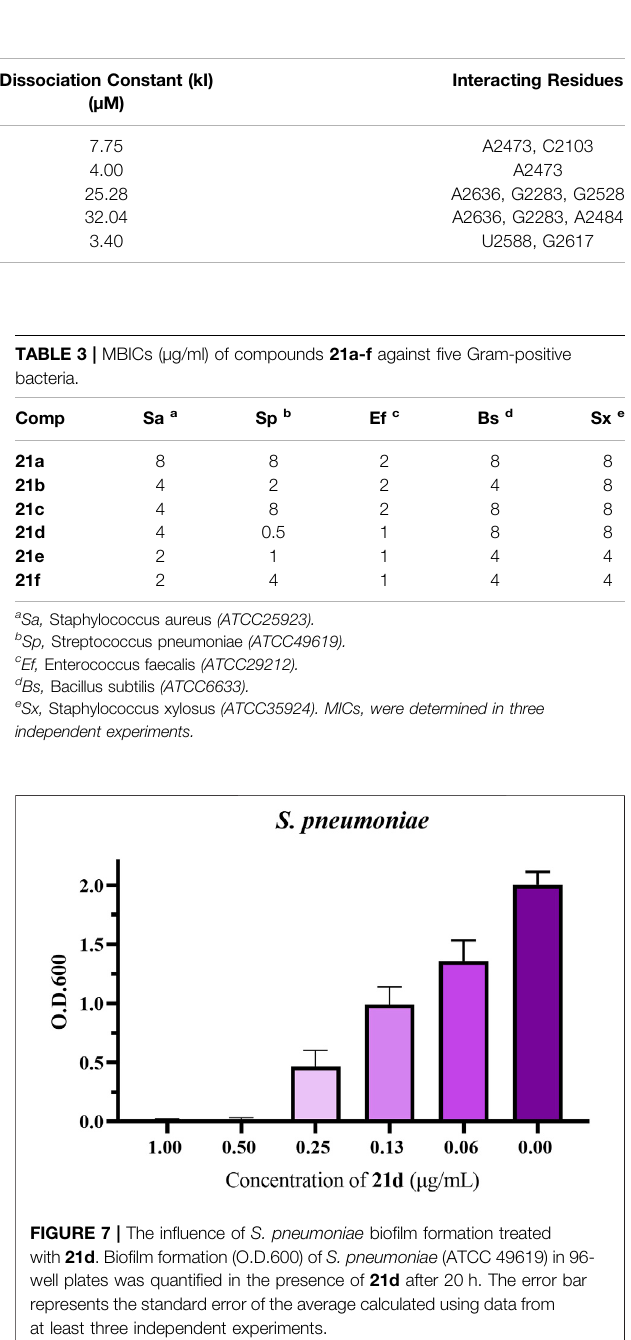
TABLE 2 | Molecular docking binding af fi nities to antibacterial targets.